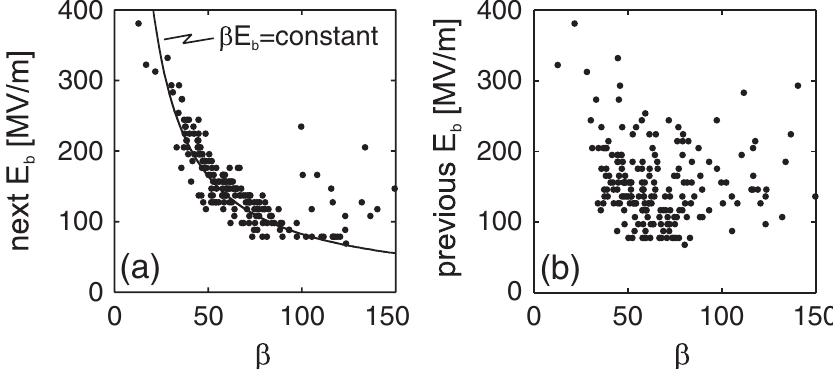
FIG. 3. Relation between the field enhancement factor (cid:1) with: (a) the next breakdown field; (b) the previous breakdown